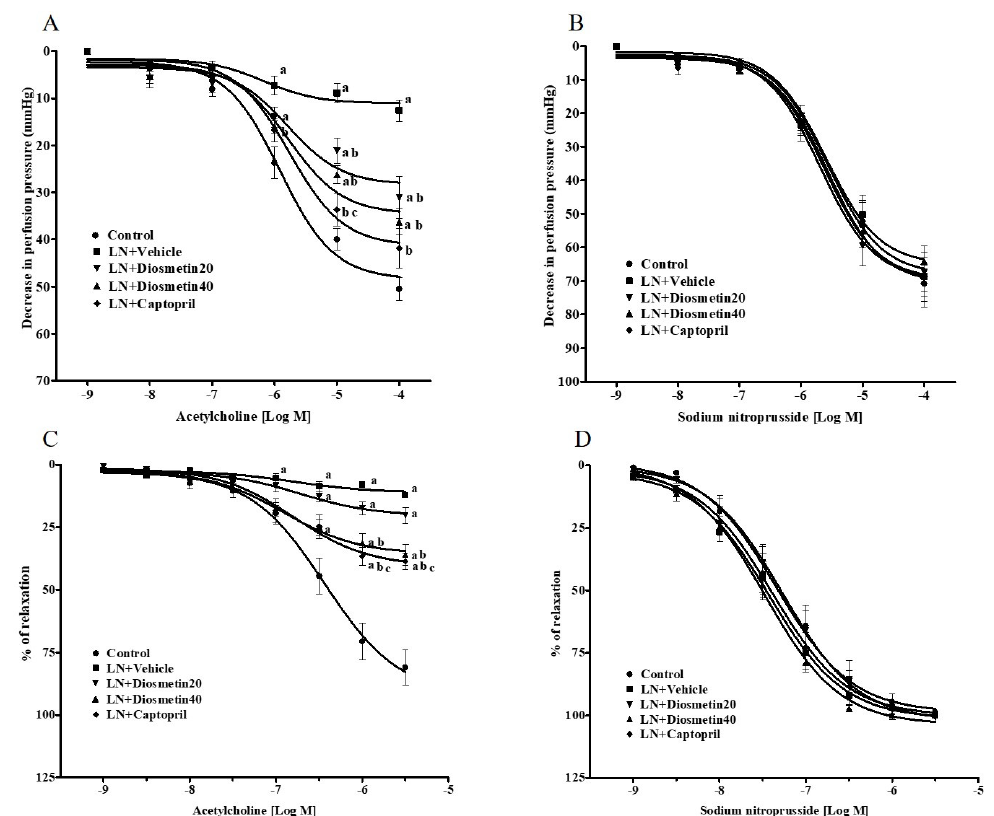
Figure 3. Effect of diosmetin and captopril on the vascular response to exogenous acetylcholine ( A ) and sodium nitroprusside ( B ) in the mesenteric vascular bed and exogenous acetylcholine ( C ) and sodium nitroprusside ( D ) aortic rings. a p < 0.05 vs. control group, b p < 0.05 vs. LN + vehicle group, c p < 0.05 vs. LN + diosmetin20 group. LN, L-NAME; LN + diosmetin20, L-NAME treated with 20 mg/kg of diosmetin; LN + diosmetin40, L-NAME treated with 40 mg/kg of diosmetin; LN + captopril, L-NAME treated with captopril ( n = 8/group). Statistical analysis between the five groups was performed using the one-way ANOVA followed by Turkey’s post hoc